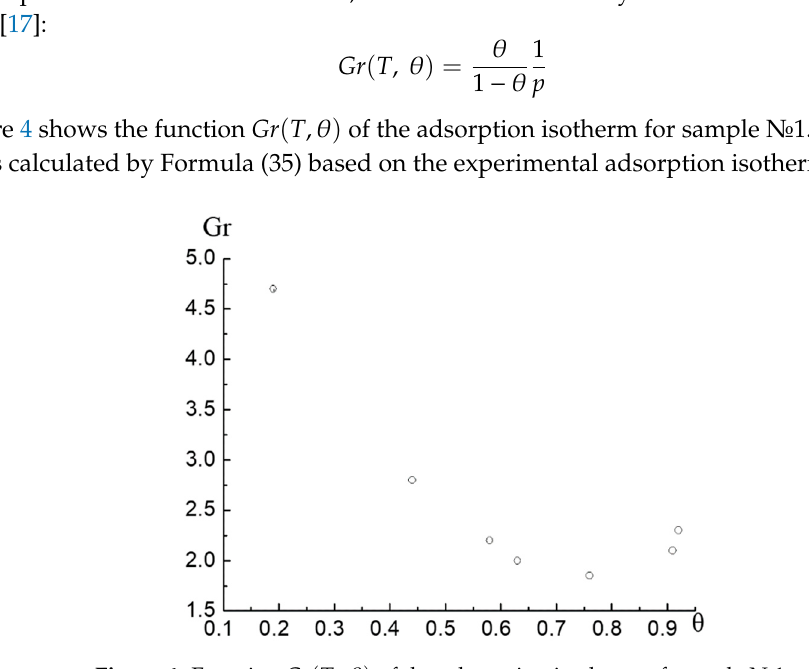
θ ) of the adsorption isotherm of sample № Figure 4. Function 𝐺𝑟(𝑇, 𝜃) of the adsorption isotherm of sample № 1. Figure 4. Function Gr ( T ,